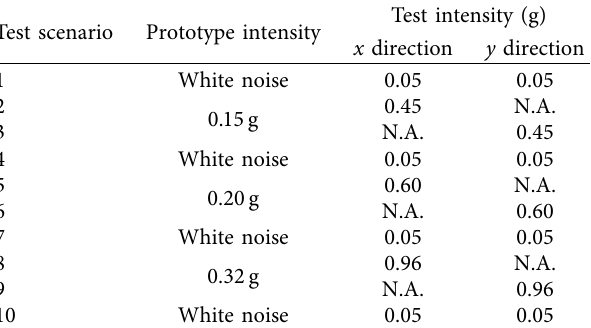
Table 4: Sequence of the shaking table test